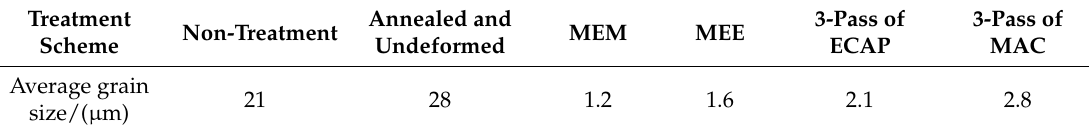
Table 3. The average grain size of Al-6061 alloy (as received state, annealed state, and after the CECC